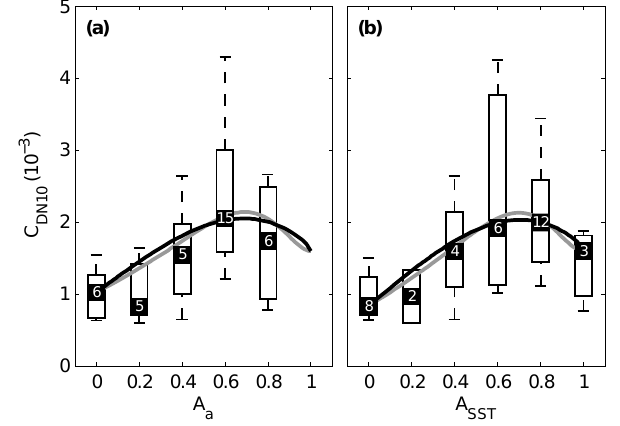
Figure 9. As in Fig. 2, but for Flight 181 only (see Table 2 for flight